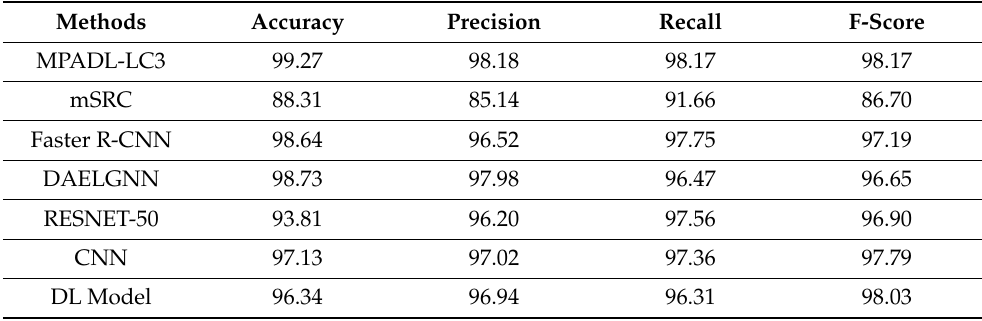
Table 4. Comparative outcome of MPADL-LC3 system with recent DL